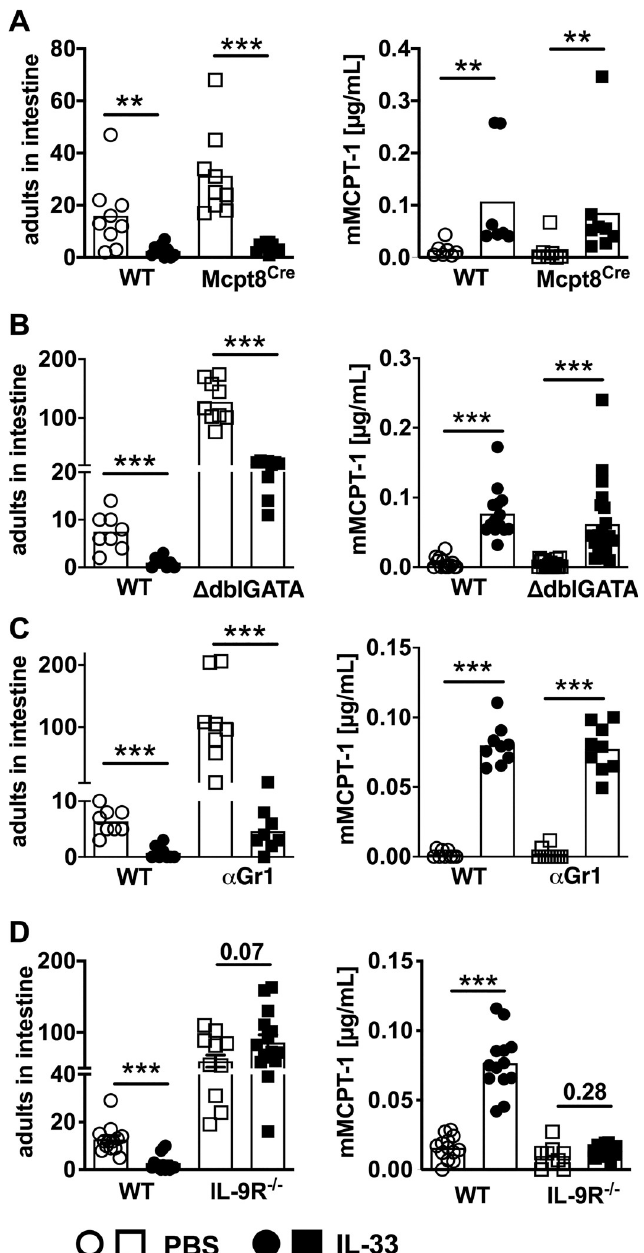
Fig 4. IL-33 mediates accelerated intestinal expulsion of S . ratti parasites independent of basophilic, eosinophilic and neutrophilic granulocytes but dependent of IL-9. (A) BALB/c Mcpt8 Cre mice (squares) and non-transgenic littermates (circles) or (B) Δ dblGATA mice (squares) and co-housed BALB/c mice (circles) or (C) BALB/c mice treated with anti Gr-1 mAb (depletion protocol and control is shown in S3 Fig) (squares) or isotype control, and (D) BALB/c IL-9 receptor-deficient mice (squares) and co-housed BALB/c mice (circles) were treated i.p. with 1 μ g of IL- 33 (closed symbols) or with PBS (open symbols) 3 h before and 24 h post S . ratti infection. mMCPT-1 concentration in the sera was quantified day 2 p.i. and parasitic adults in the intestine counted day 6 p.i. Graphs show combined results from 2–4 independent experiments (n = 3–8 per experiment and group). Each symbol represents an individual mouse, bars show the mean, asterisks indicate statistically significant differences of the mean, numbers indicate p value (Mann-Whitney and students t-test).